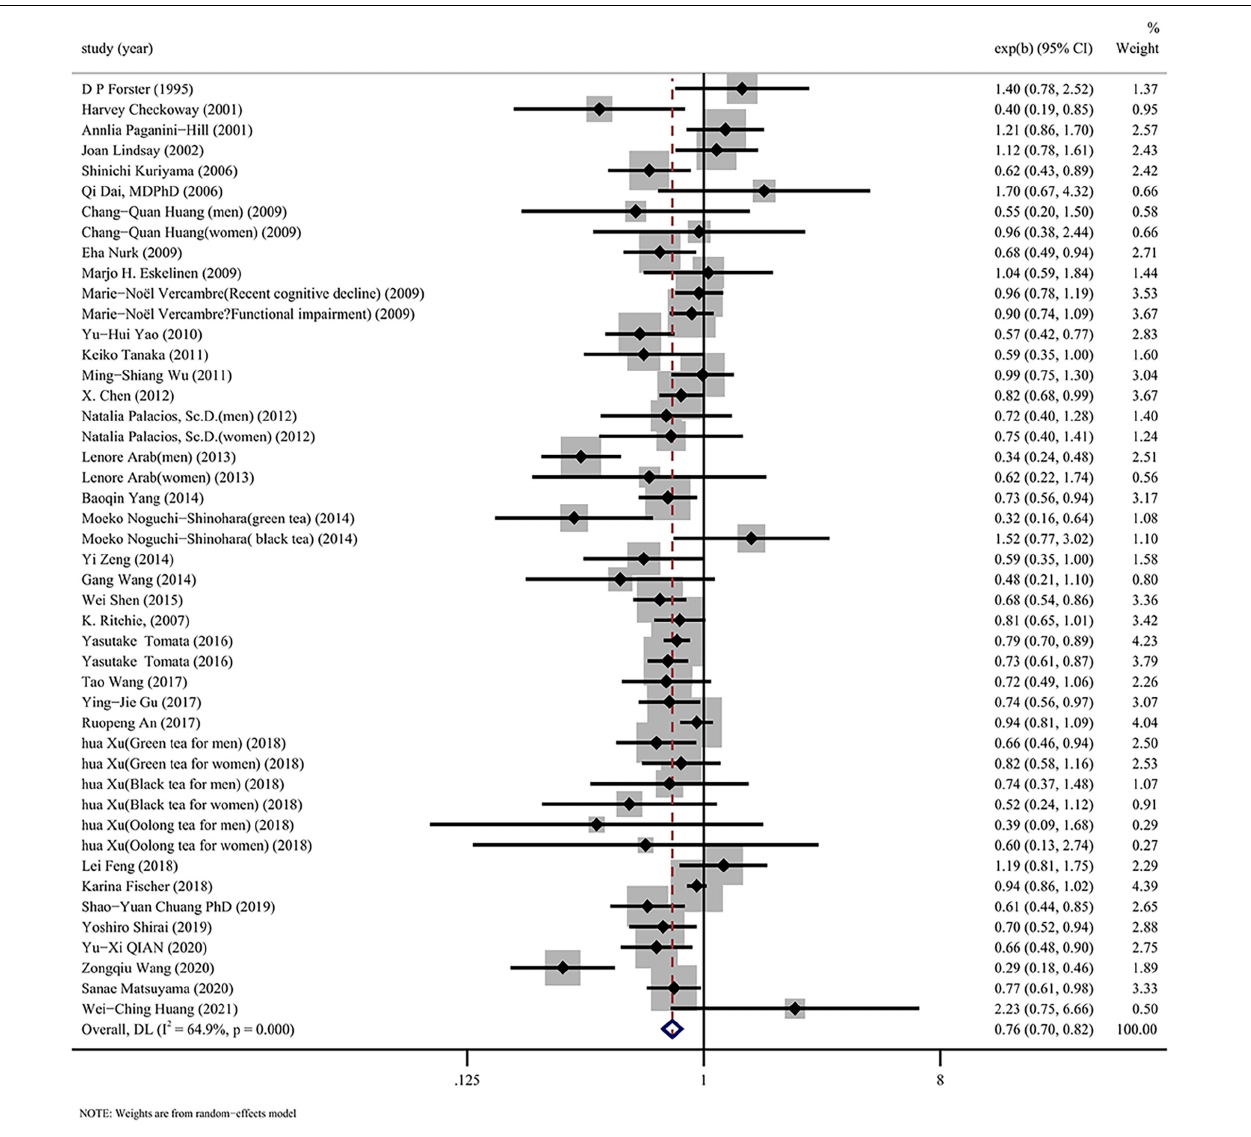
FIGURE 2 | Overall pooled analysis of association between tea drinking and the cognitive